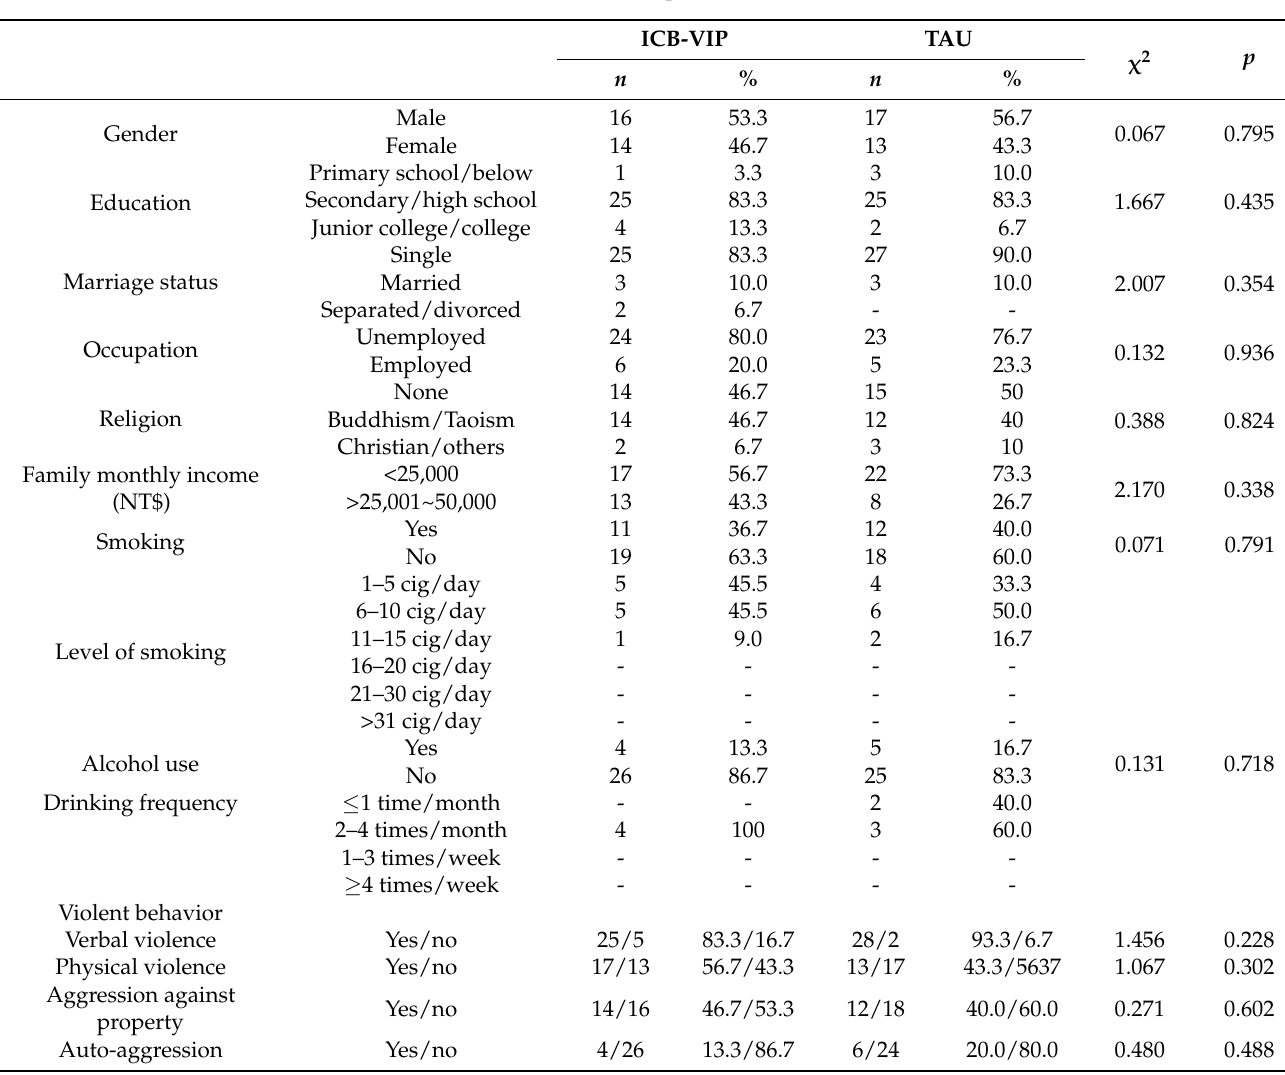
Table 1. Characteristics of patients at